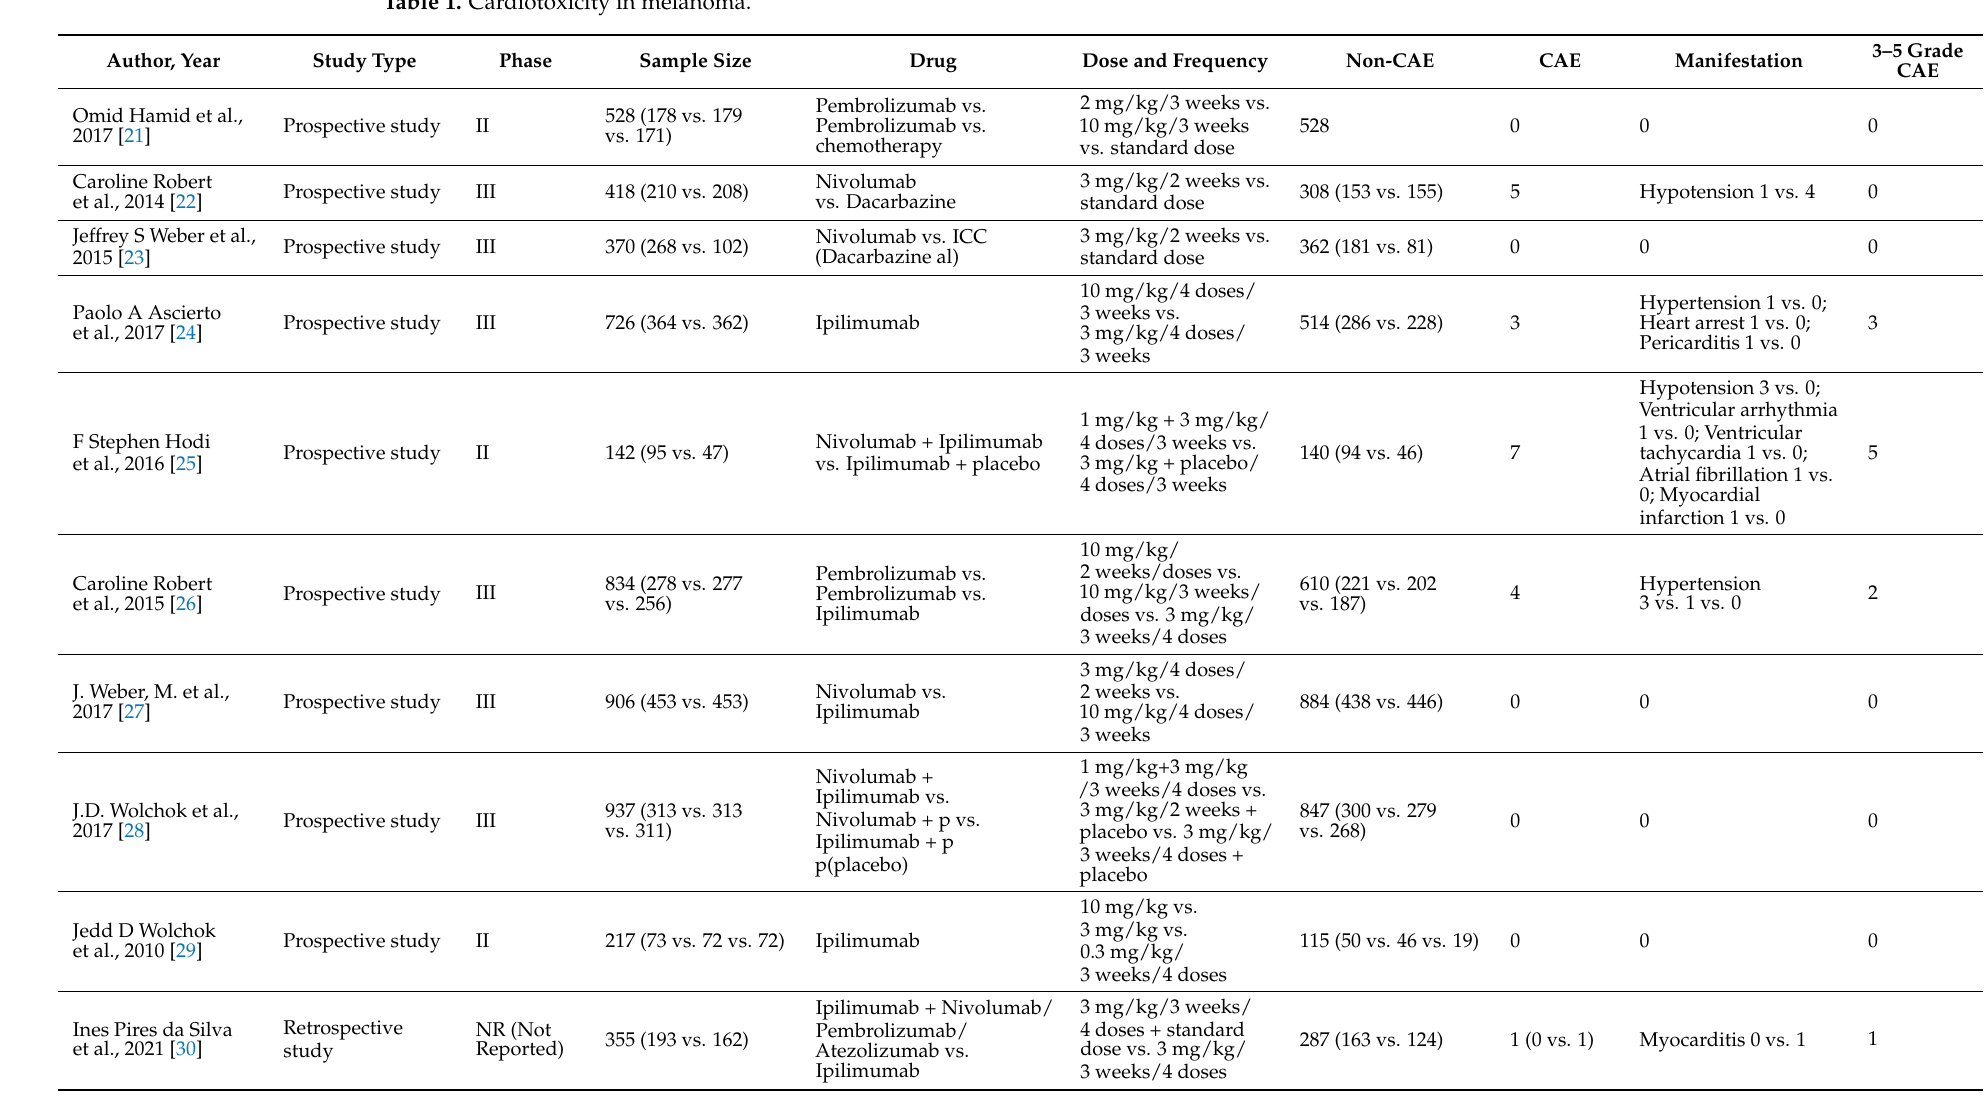
Table 1. Cardiotoxicity in